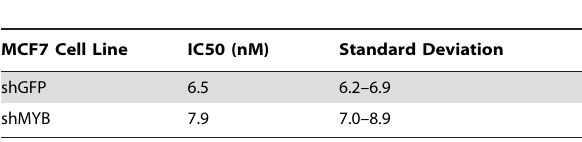
Table 1. 72 h inhibitory concentration (IC50) for tamoxifen in MCF7 lines.